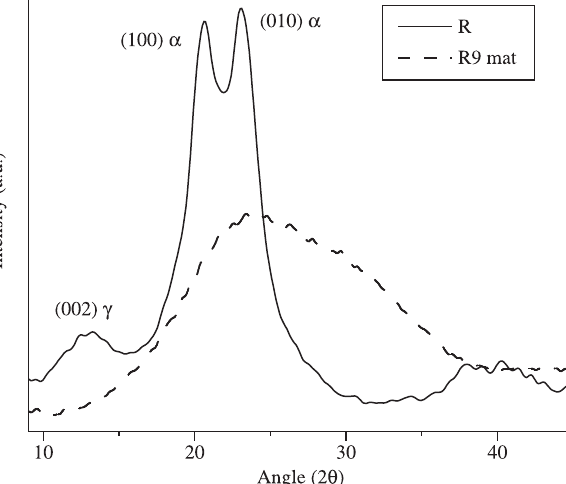
Figure 9. Diffractograms of sample R and R9 mat.